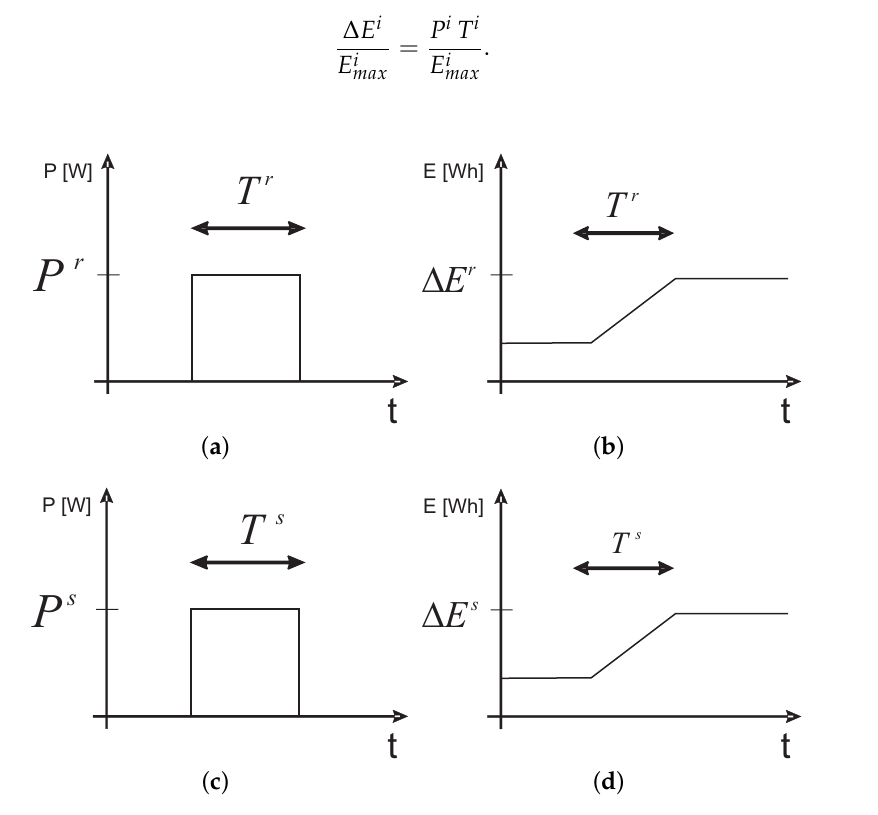
Figure 9. ( a ) Real system, net power P r ; ( b ) real system, energy variation ∆ E r ; ( c ) scaled system, net power P s ; ( d ) scaled system, energy variation ∆ E s